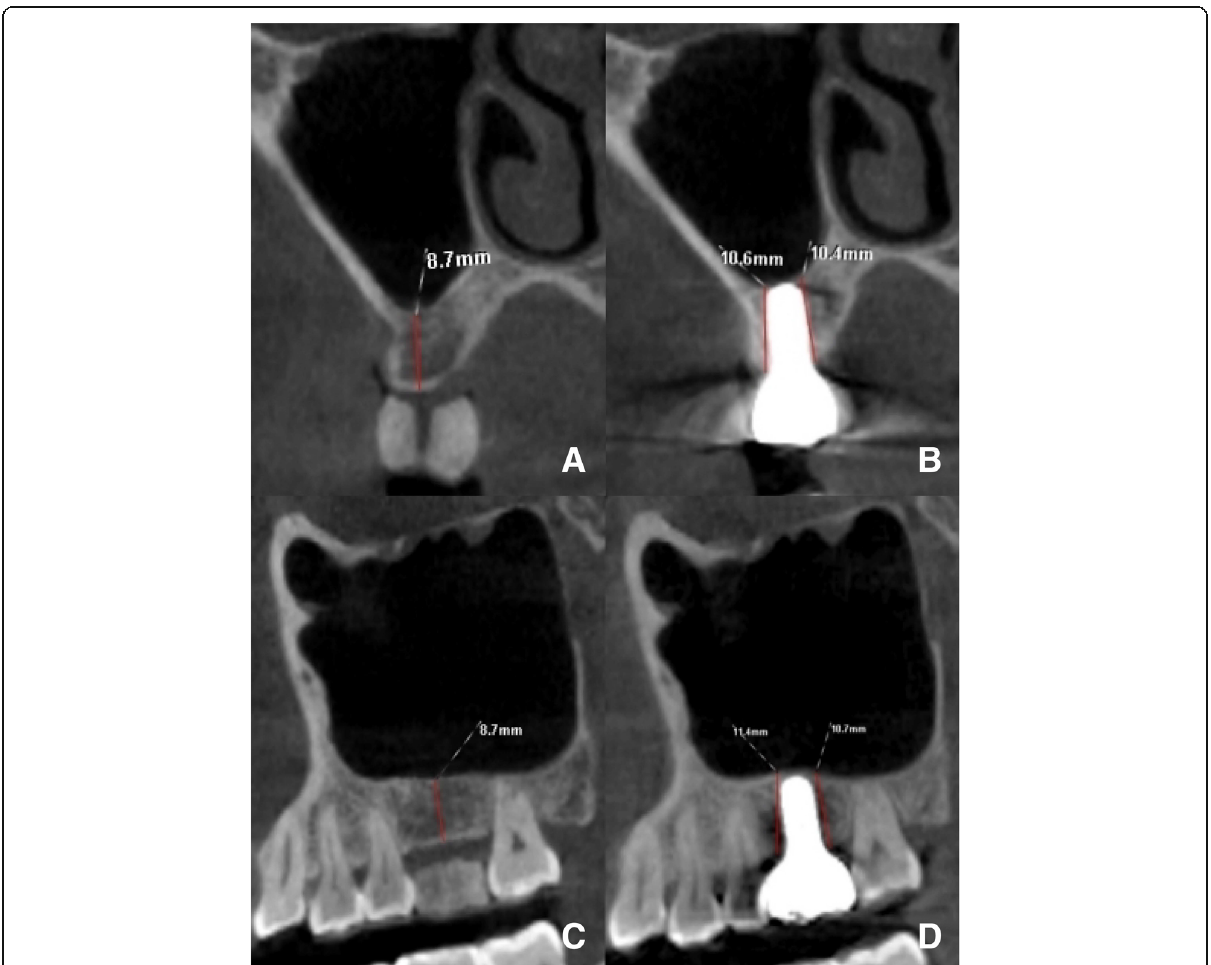
Fig. 2 Case 2: The CBCT images of implant site 16 before (left column) and 6 months after surgery (right column). The residual bone height (RBH) was measured from the cortex bone to the alveolar bone crest under the sinus floor in a coronal and c sagittal views. The new bone level was measured from the most coronal implant thread to the most apical visible implant at b buccal and palatal sites in coronal view and d mesial and distal sites in sagittal view